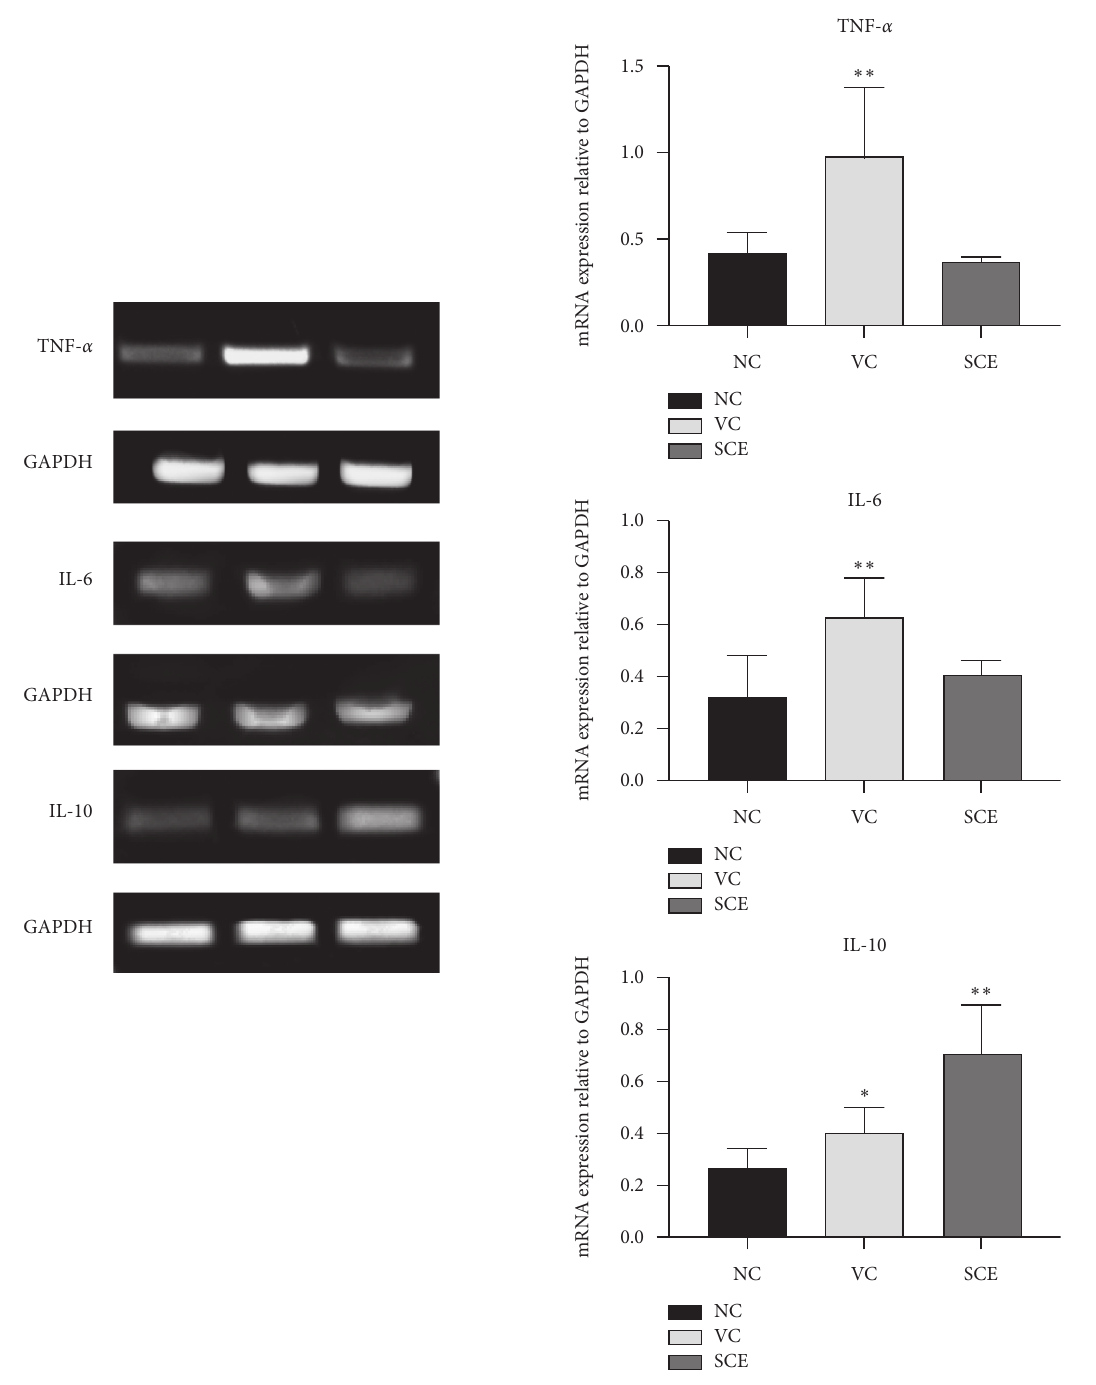
Figure 6: Semiquantitative PCR analyses for determination of mRNA level expression of target genes TNF- α , IL-6, and IL-10. ∗∗ Significantly different compared to control (NC); P < 0 . 05. ∗∗ Highly significantly different compared to control (NC); P < 0 .